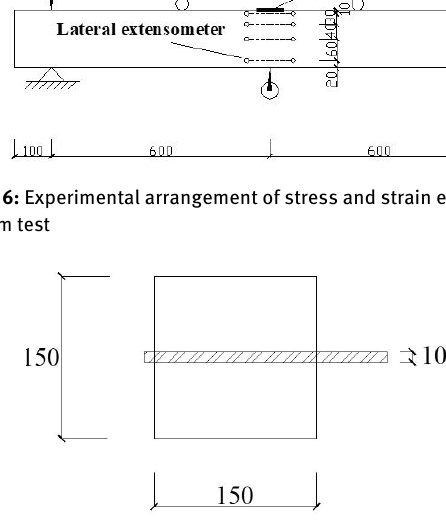
Figure 7: Schematic illustration of the central pullout